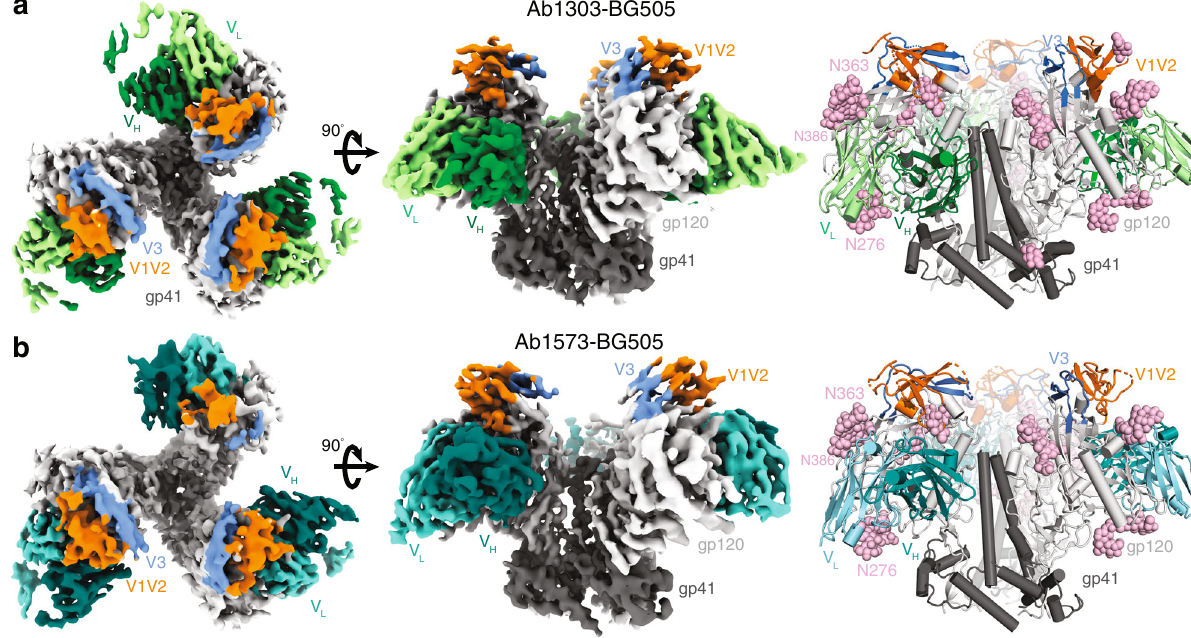
Fig. 2 Cryo-EM maps and atomic models of Ab1303-BG505 and Ab1573-BG505 complexes. a , b Cryo-EM density maps of Ab1303-BG505 ( a ) and Ab1573-BG505 ( b ) complexes shown from the top (left) and side (middle). Right: cartoon diagrams of the structures with N -linked glycans shown as pink spheres. Highlighted in colors include: gp120 subunits (light gray), gp41 (dark gray), Ab1303 VH (dark green) and VL (pale green) domains and Ab1573 VH (dark teal) and VL (light teal) domains. The gp120 V1V2 and V3 regions are shown in orange and blue,